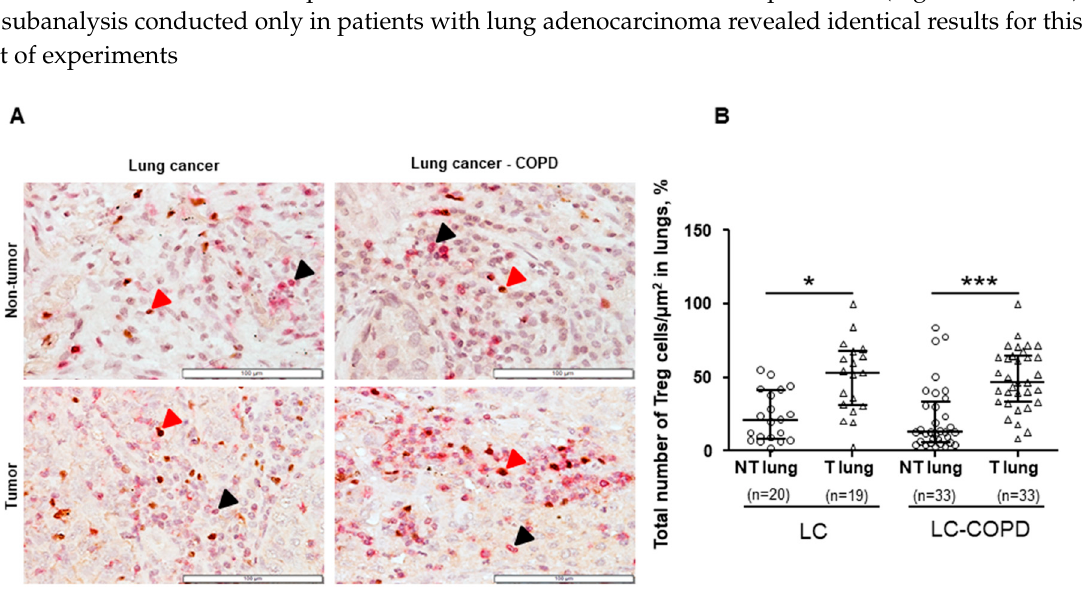
Figure 2. ( A ) Representative examples of double immunohistochemical staining for NK cells (NCR1+) in LC and LC–COPD patients, respectively. Black arrows point toward NK cells negatively stained in blue with hematoxylin, and red arrows point toward NK cells (NCR1+) stained in brown. ( B ) Median and interquartile ranges between 75th and 25th percentiles of proportions of NK cells in the total measured area. Comparisons were made between the non-tumor (NT) and tumor (T)